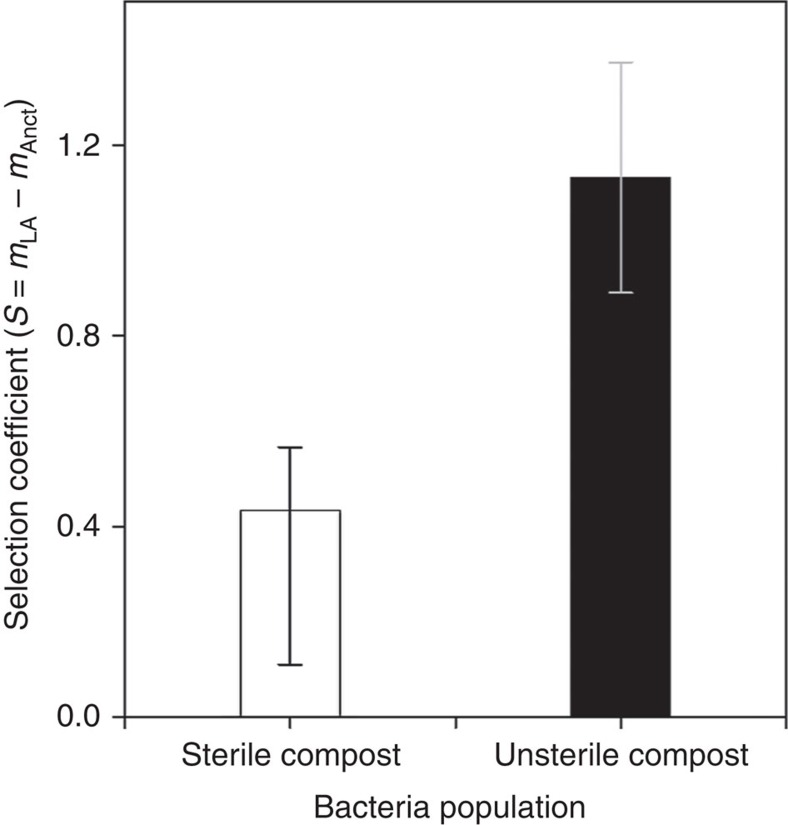
Fitness of locally adapted SBW25.Mean (±s.e.m.) selection coefficient of evolved SBW25 (after 48 days cultivation in sterile compost at 26 °C) determined by competing against its ancestor for 5 days in both sterile and unsterile compost. Note that selection coefficient (S) was calculated here by the difference between the estimated Malthusian parameter of the locally adapted SBW25 population (mLA) and the ancestral SBW25-lacZ strain (mAnct), where a value of zero indicates equal fitness.